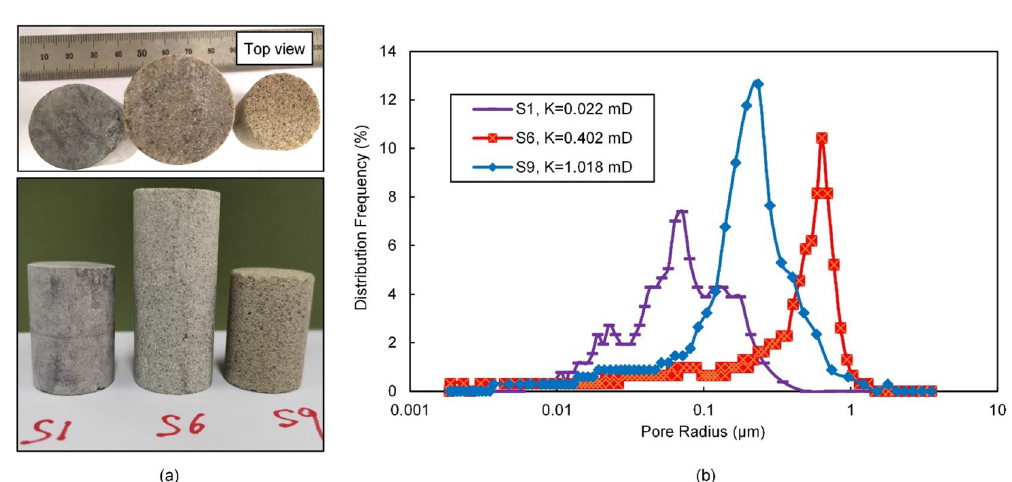
Figure 1. Experimental samples, ( a ) Photographs of samples S1, S6, and S9; ( b ) High-pressure mercury injection test results for samples.